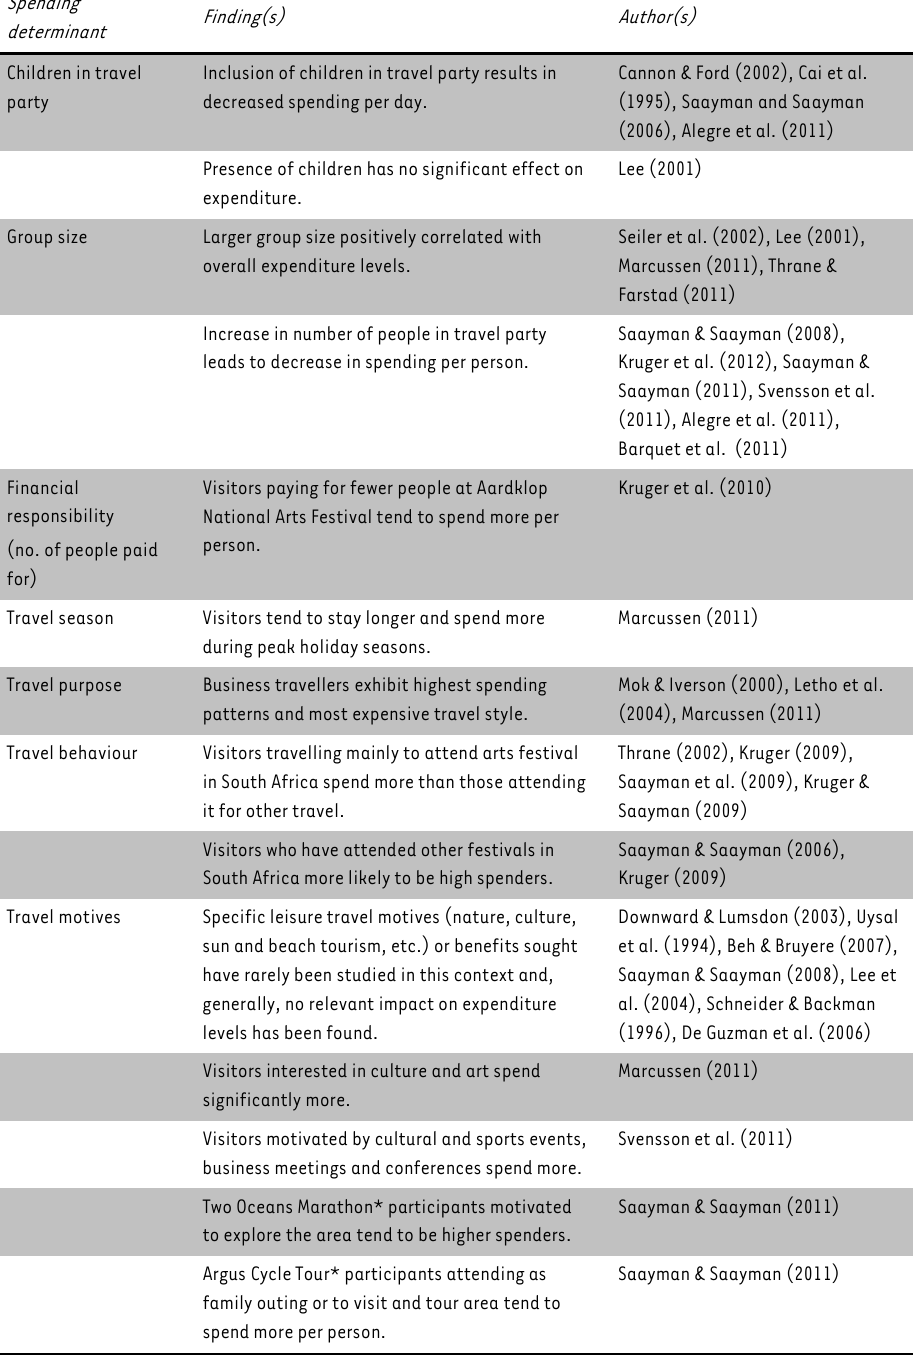
Survey of the literature on behavioural determinants of visitor